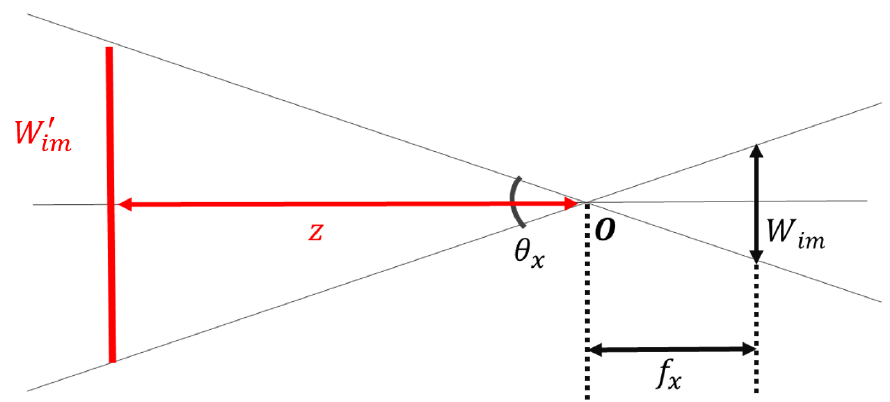
Figure 3. Pinhole camera model observed from the y -axis direction: θ x is the angle of view in the x -axis direction, f x is the focal length along the x -axis, W im is the width of the image, and W (cid:48) width of the image on the projection plane.